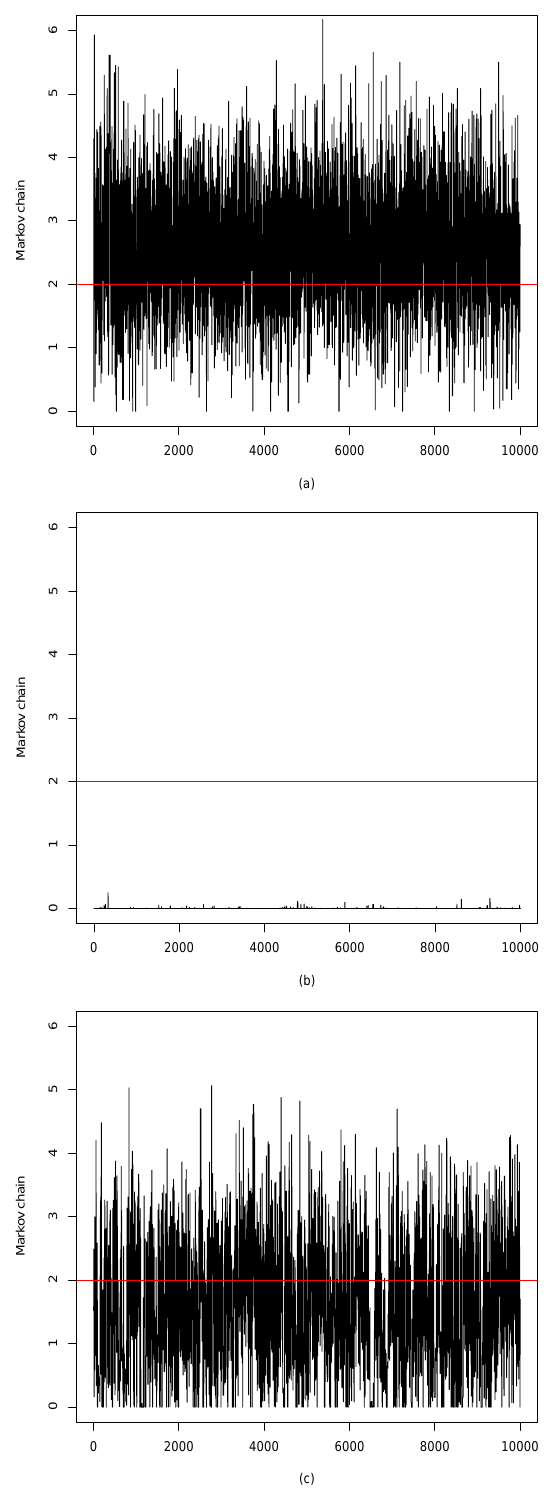
Figure 11. The Markov chain of ˜ b 1 via using ( a ) domain I, ( b ) domain II, and ( c ) domain III: The straight line is the true value of b 1